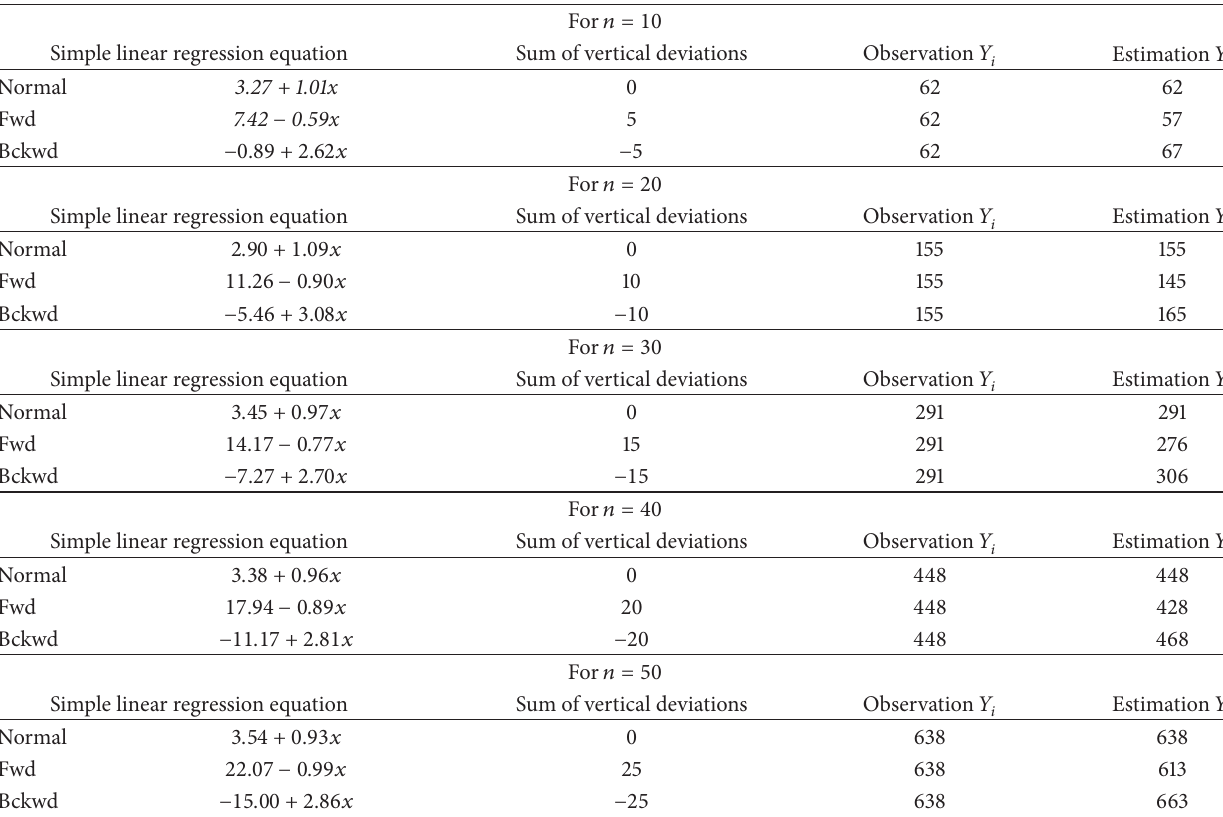
Table 1: Values for results